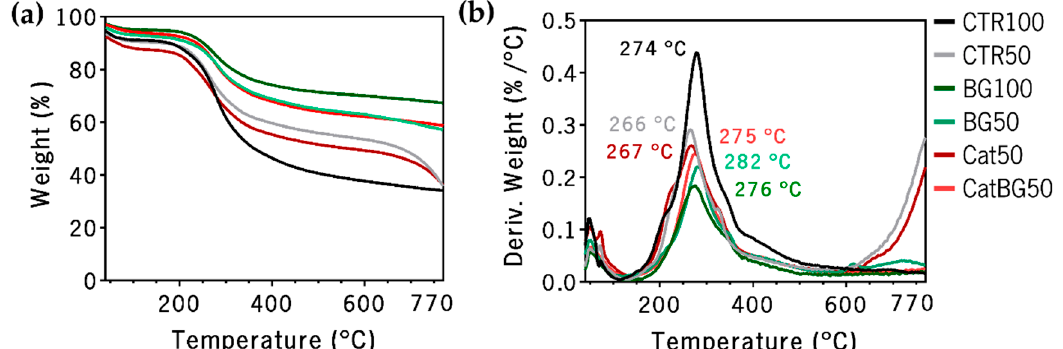
Figure 8. TGA thermograms of ( a ) weight loss and ( b ) derivative of the weight loss (DTGA) of the freestanding LbL films as a function of temperature.